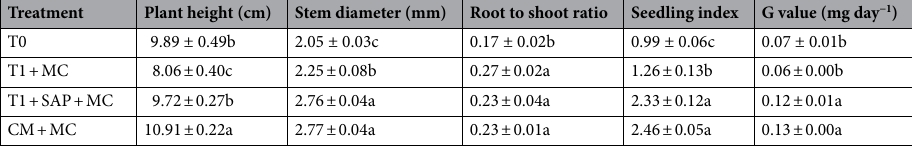
Table 8. Effects of different growing media combined with MC application on growth parameters of cotton seedlings. CM commercial media, SAP super absorbent polymer, MC mepiquat chloride foliar painting at the one-true-leaf stage.